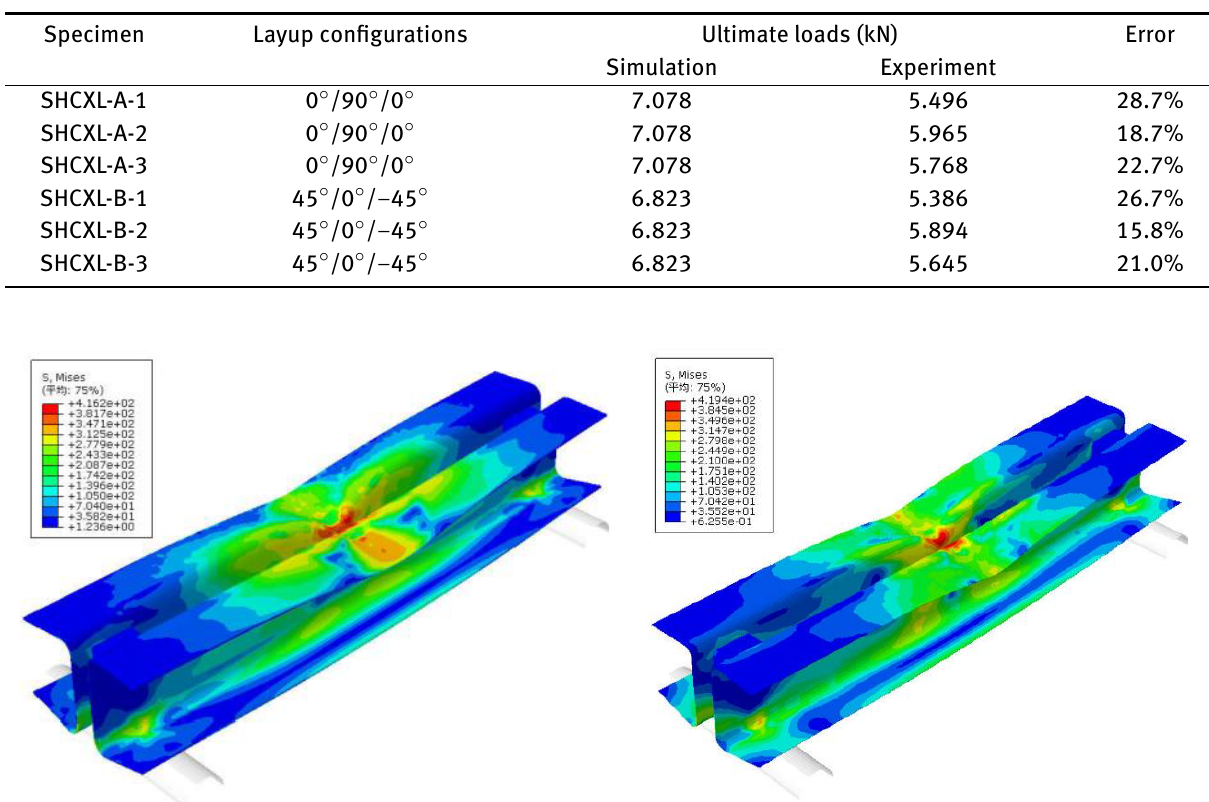
Table 3: Comparison of ultimate bearing capacities obtained in numerical simulation and experiment.